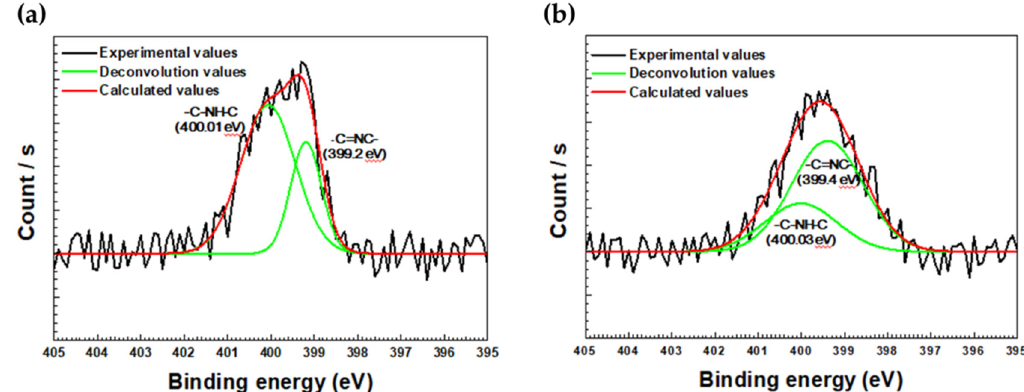
Figure 7. XPS results (N1s) of carbon steel weldment after 6 h immersion in ( a ) 500 ppm and ( b ) 1000 ppm of imidazole. Table 4. The area ratio between –C=NC and –C-NH-C peaks from N 1s XPS results .